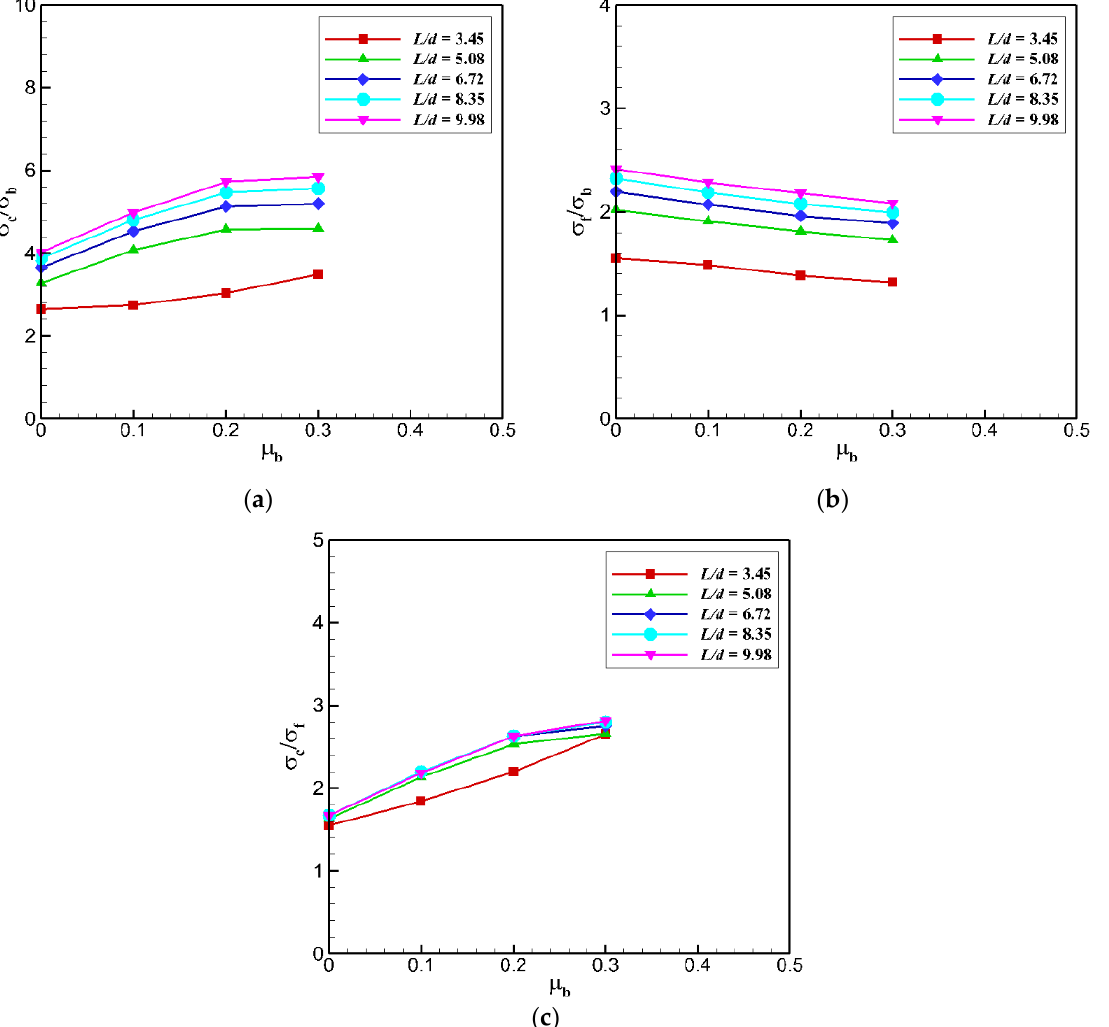
Figure 15. Effect of bond friction coefficient: ( a ) ratio of simulated compressive strength to bond strength; ( b ) ratio of simulated flexural strength to bond strength; ( c ) ratio of simulated compressive strength to flexural strength.